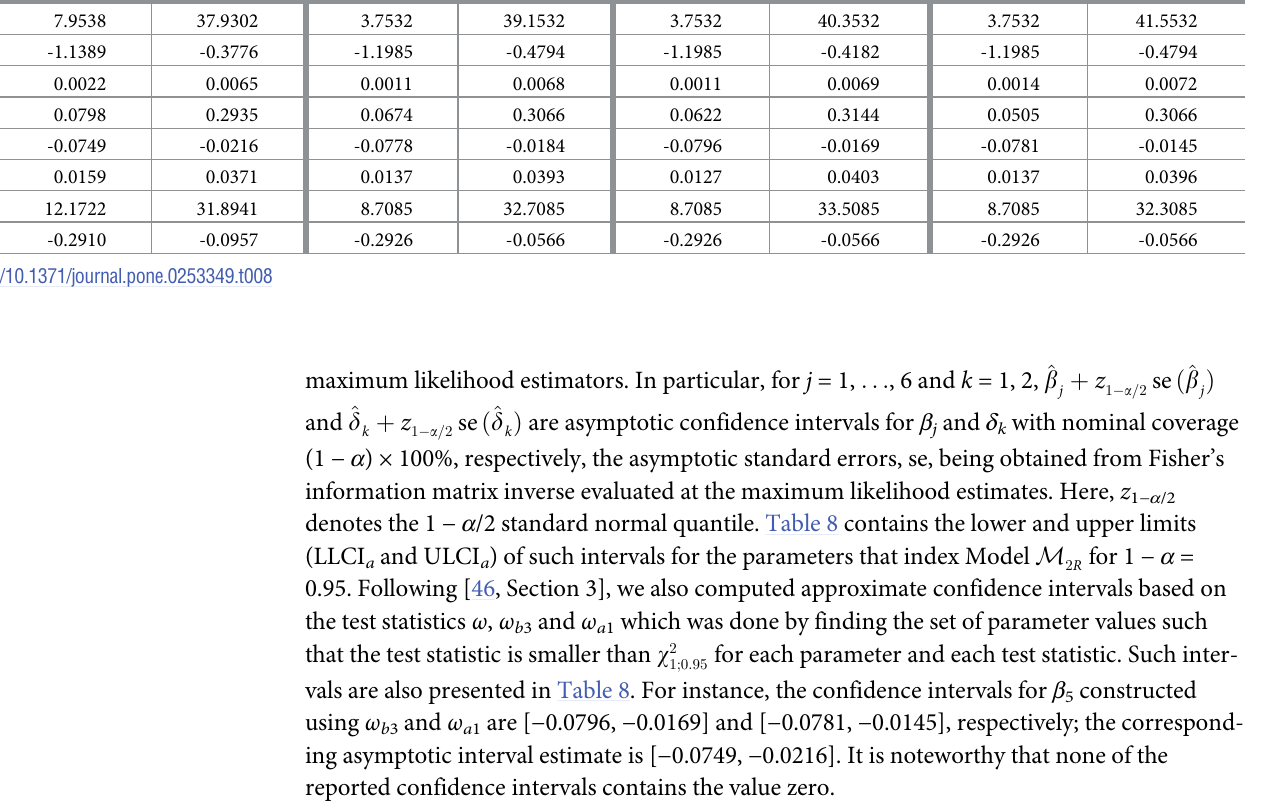
Table 8. Lower (LLCI) and upper (ULCI) asymptotic confidence intervals limits for the parameters of Model M fidence intervals constructed using the test statistics ω , ω